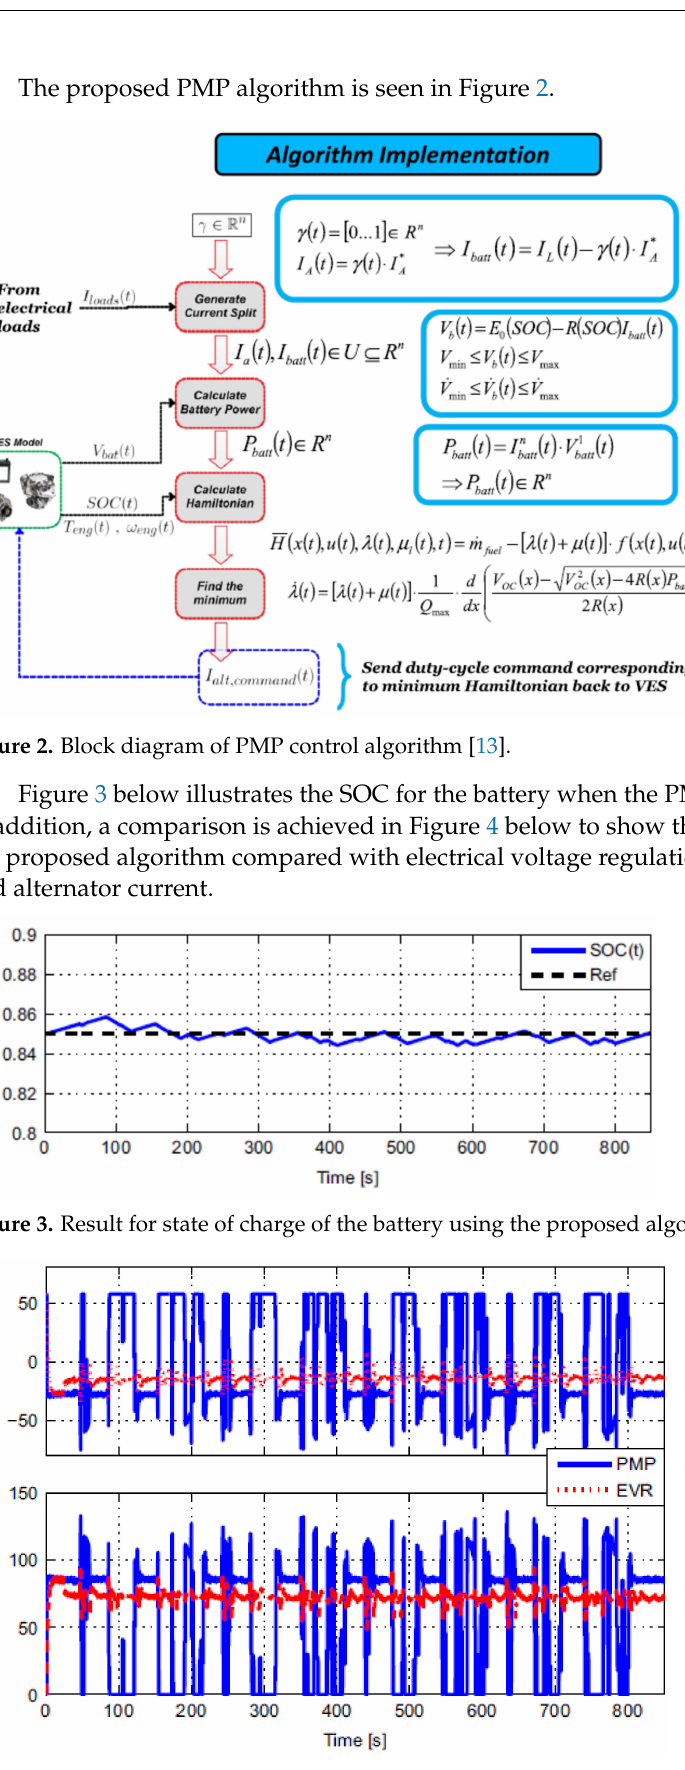
Figure 4. Battery and alternator current for the PMP and EVR algorithms